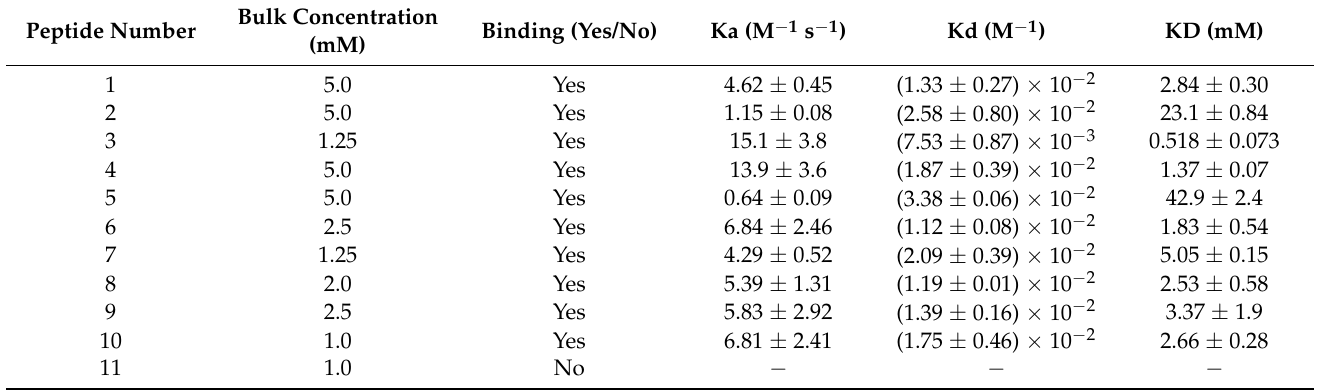
Table 2. Binding kinetics of synthesized peptides to SARS-CoV-2 spike protein